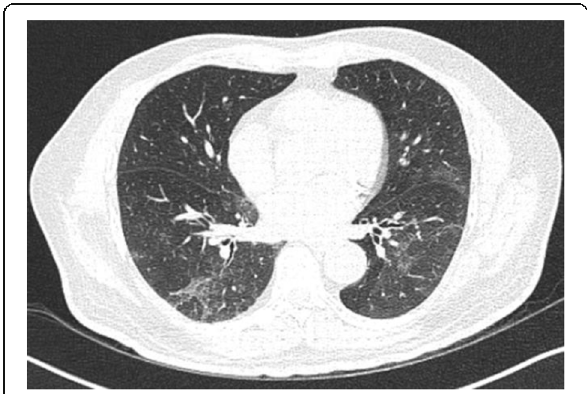
Fig. 16 Chest CT showing few bilateral ground glass